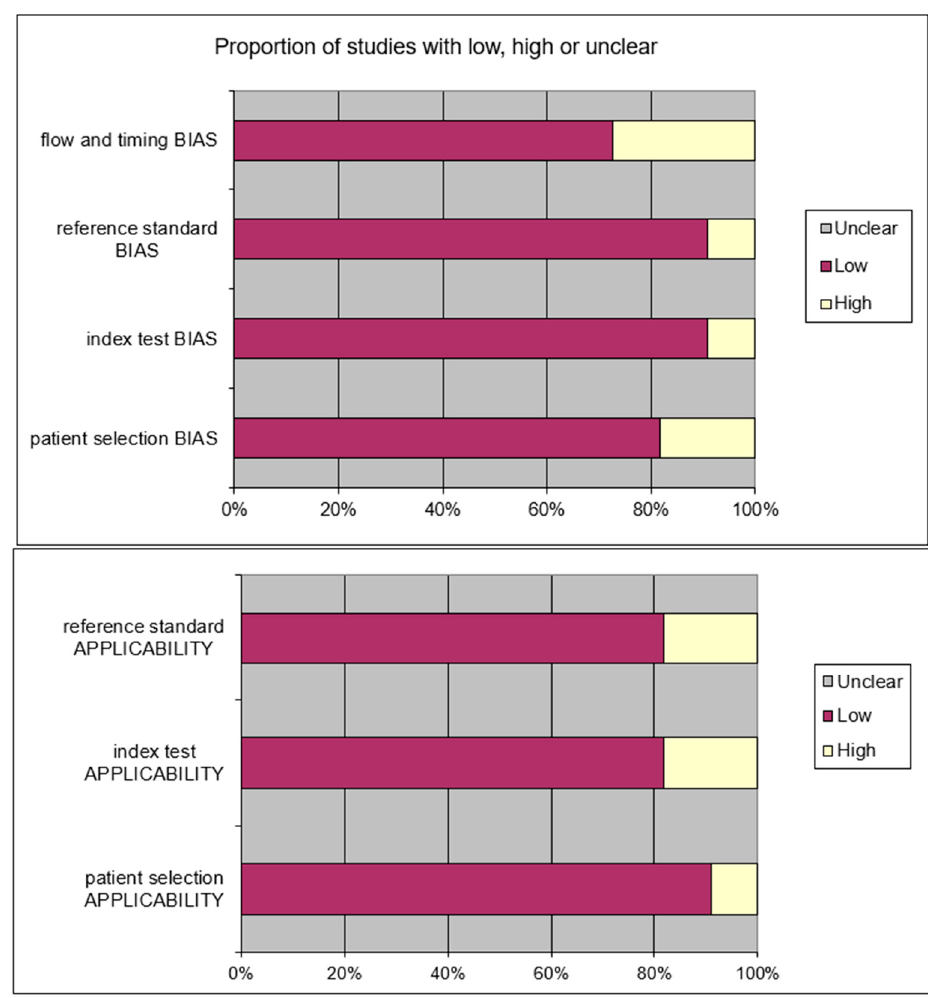
Figure 2. QUADAS2 risk of bias.